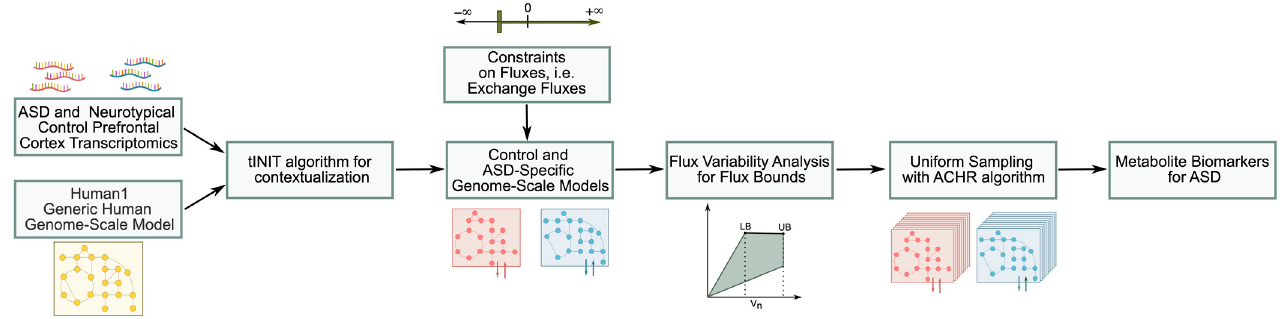
Figure 1. Flowchart for the biomarker investigation.